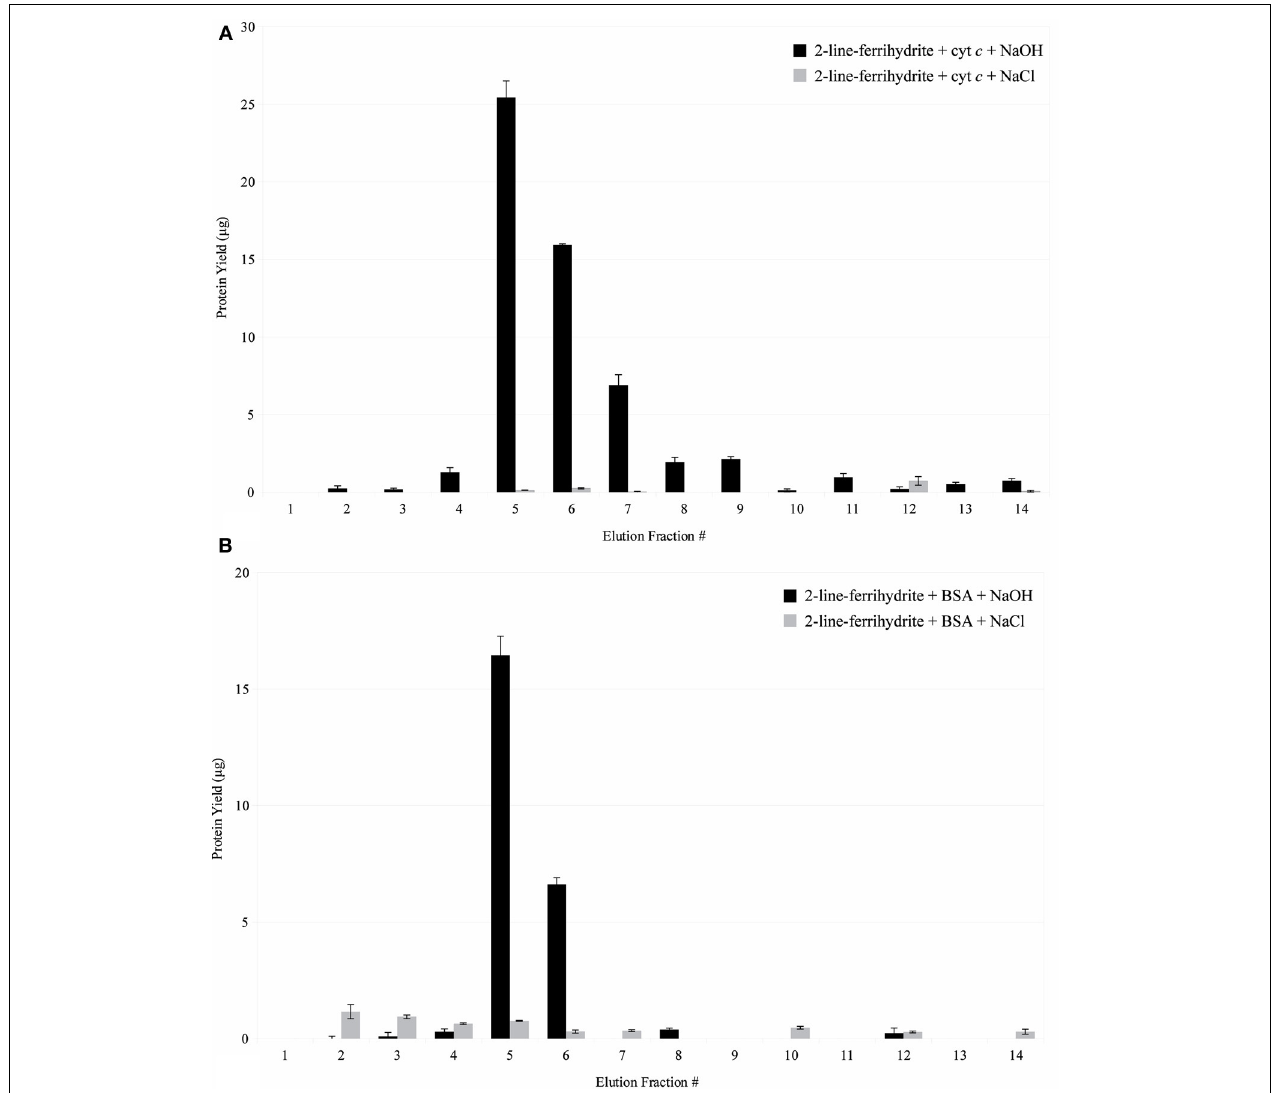
FIGURE 11 | (A) Interaction of cytochrome c with synthetic iron oxyhydroxide. Fractions 1–4 were eluted in 20mM sodium acetate buffer, pH 5.25. Fractions 5–14 were eluted in 0.1N NaOH or 1M NaCl. Error bars indicate ± one standard deviation from the mean.